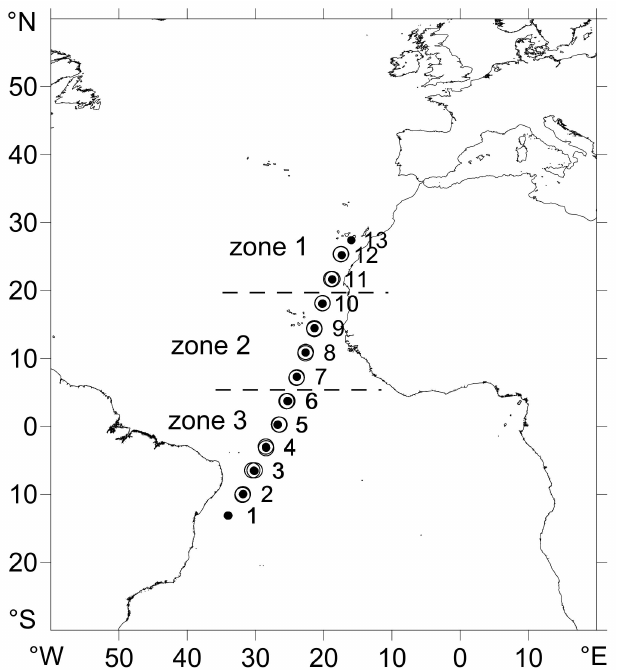
Figure 1. The position of the studied stations in April 2015. Dots indicate conductivity-temperature- depth (CTD) profiles and bottle casts and circles the stations where plankton samples were collected. Stations were grouped in three zones according to the distribution of hydrographic and chemical variables (see Figure 2 and Supplementary Table